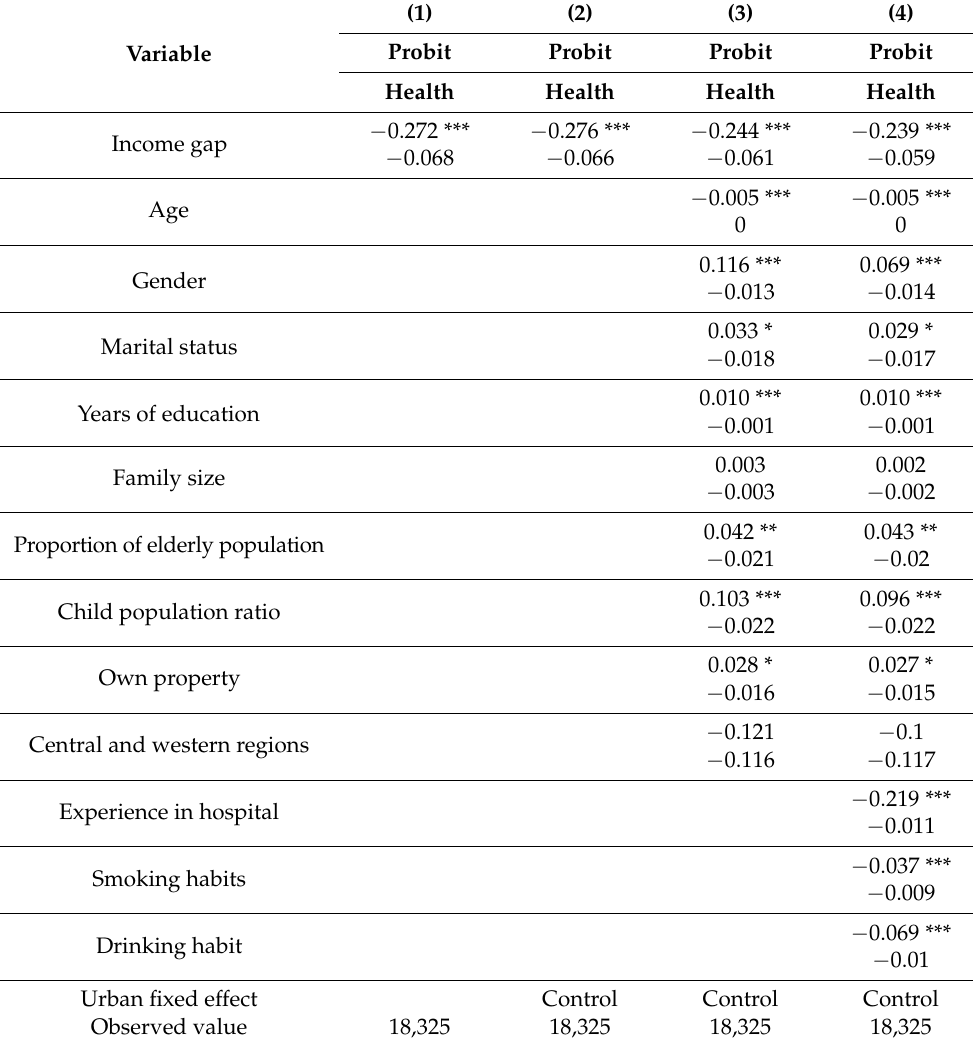
Table 3. Impact of income gap on health of rural